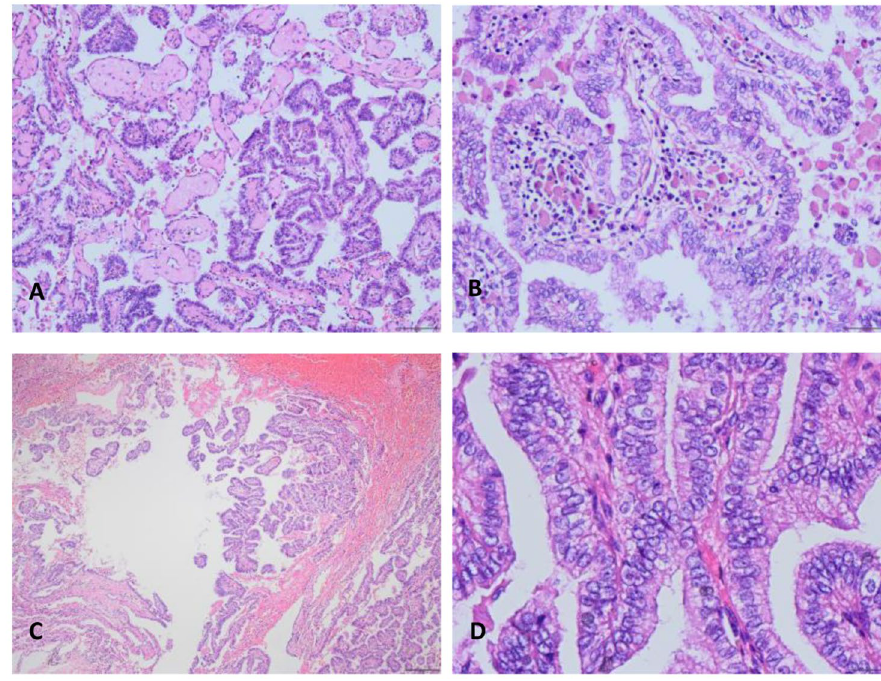
Fig. 3 Morphological features of the tumor. A, The tumor was composed of branched papillae with fibrovascular cores, and partial papillary cores hyalin- ized (100×). B, The fibrovascular core was infiltrated with lymphocytes and histiocytes, cilia can be seen (200×). C, The tumor protruded into the surround- ing lung tissue in a mushroom-shaped without pro-fibrointerstitial reaction around (40×). D, The tumor cells were crowded and arranged pseudostratified with obvious nucleoli